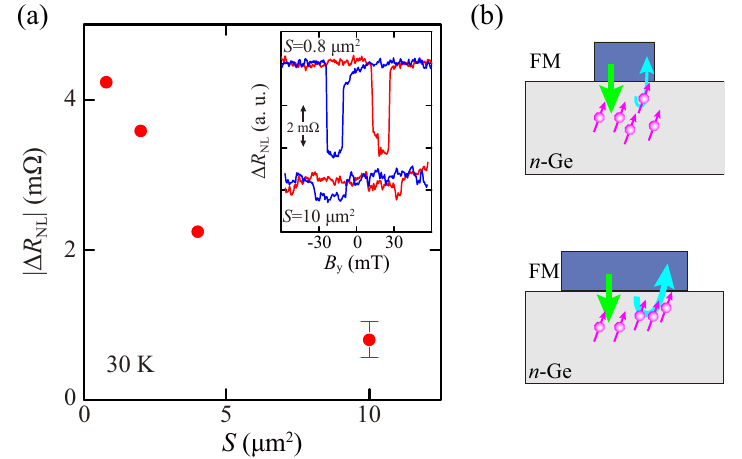
Figure 4. ( a ) S dependence of | ∆ R NL | at 30 K. The inset shows the nonlocal spin signal for the LSVs with S = 0.8 and 10 µ m 2 ; ( b ) Schematic diagram of spin absorption effect under the small and large FM contacts.